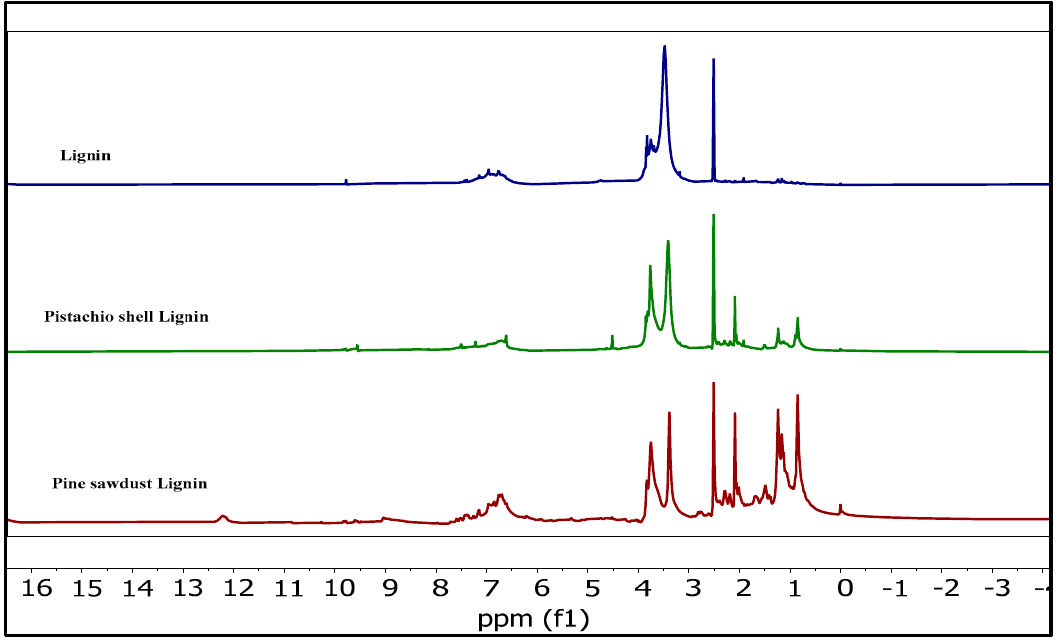
Figure 4. 1 H-NMR spectrum of extracted lignin from pine sawdust and pistachio shells compared with commercial lignin. with commercial lignin. Table 2. 1 H NMR chemical shifts and functional groups of extracted lignin from pine sawdust and pistachio